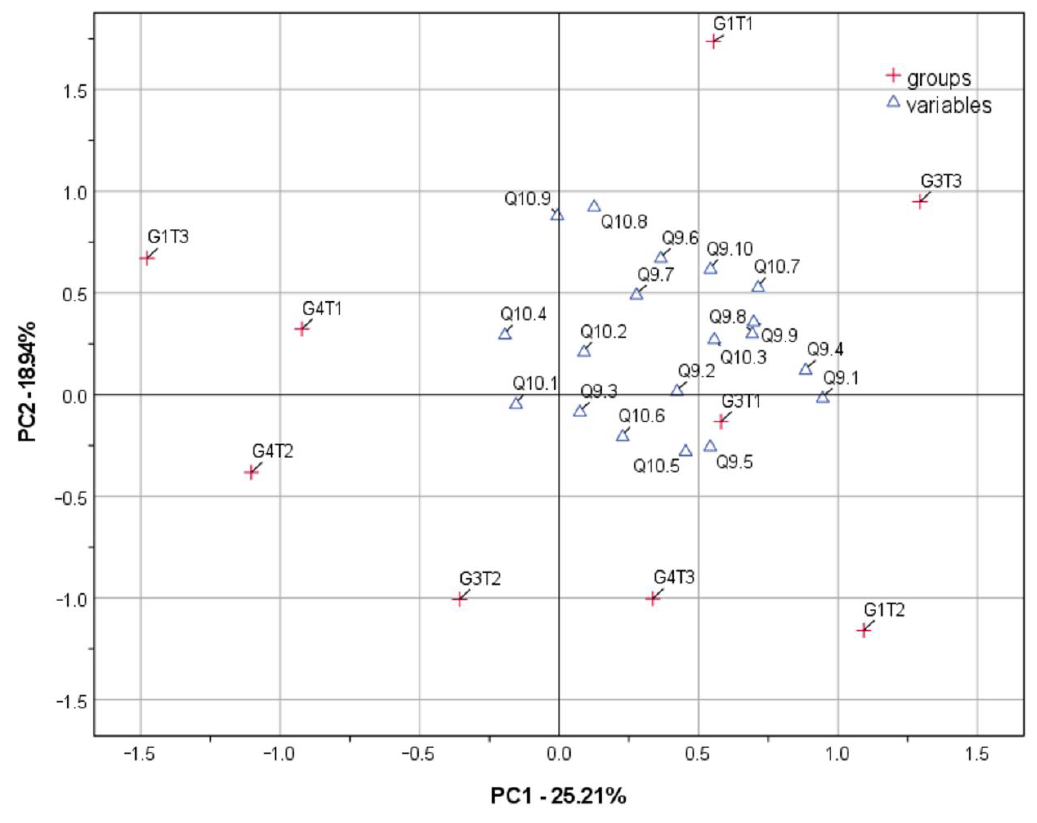
Figure 1. Biplot of relationships of variables (Q9.1, . . . , Q9.10, Q10.1, . . . , Q10.9) for groups (G1T1, . . . , G1T3, G3T1, . . . , G4T3) representing types of organization subdivided according to the declared level of trust in the space of the first two components PC1 and PC2.